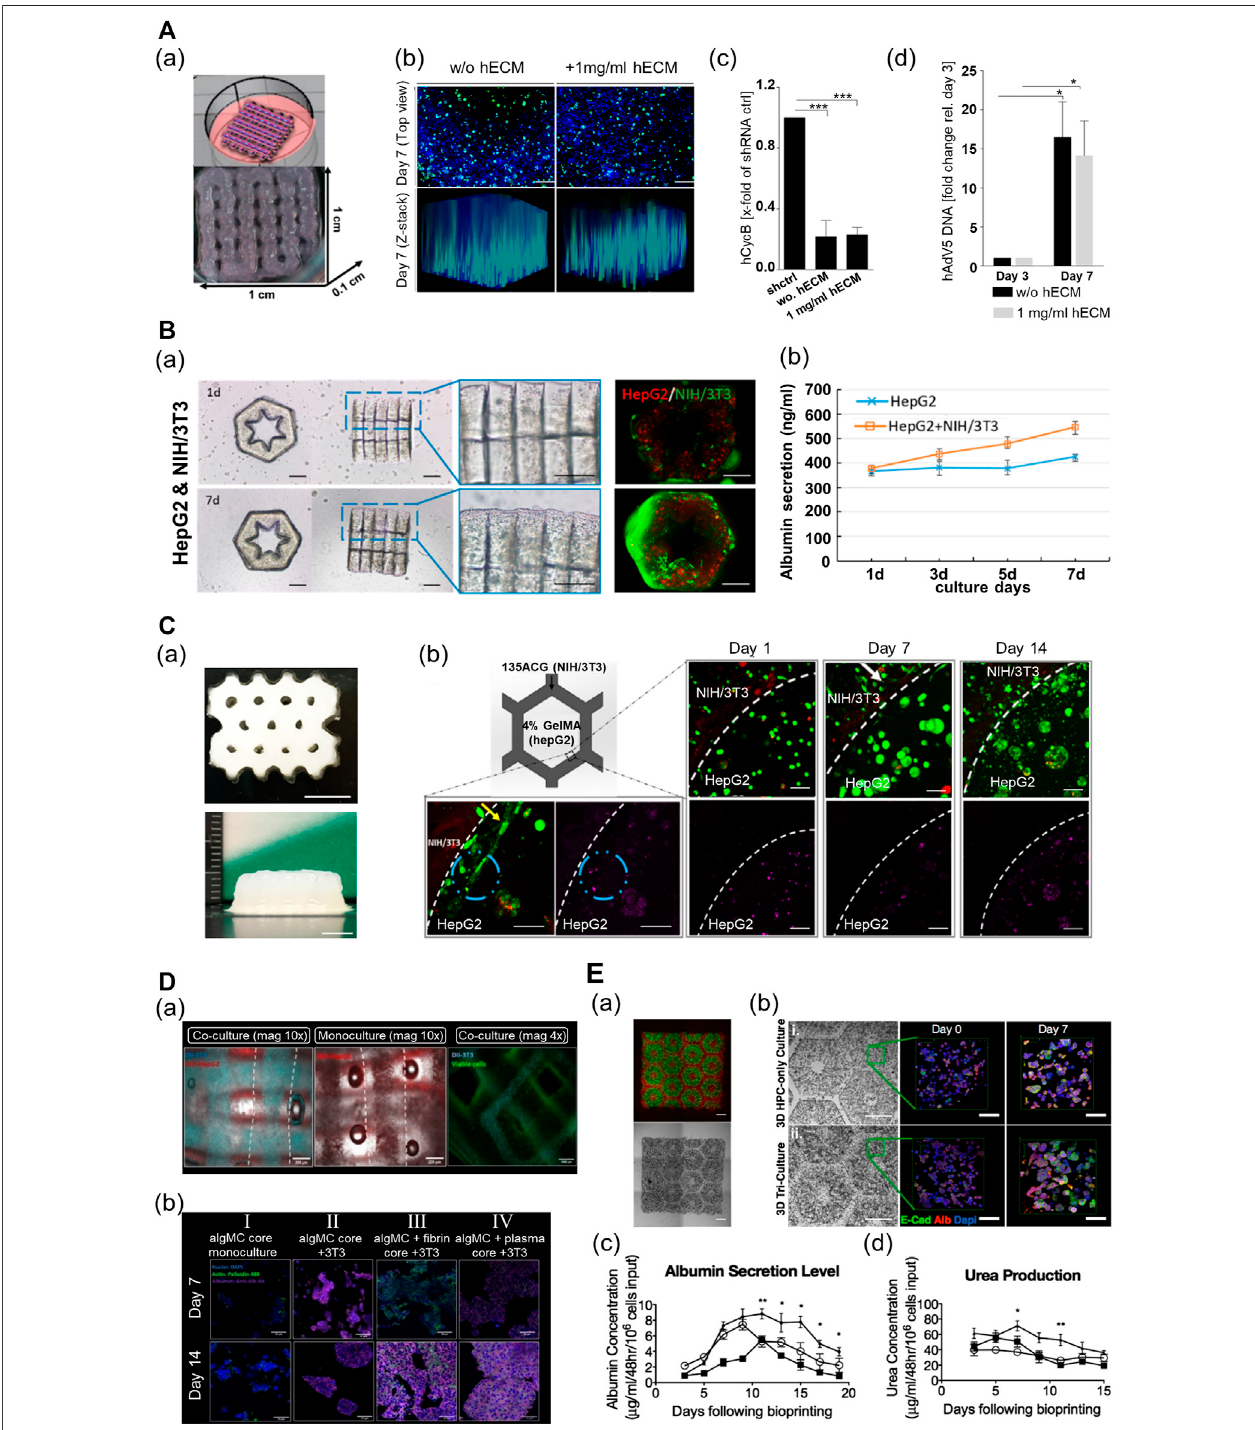
FIGURE7| Multi-componenthydrogelbioink-based3D-printedlivertissuemodels. (A) 3D-printedlivertissueforinfectionandtransduction studies.(a)3D-printed liver tissue construct with HepaRG cell-laden hybrid alginate – gelatin – human extracellular matrix (hECM). (b) Comparison of AAV2.6 transduction and distribution within the multi-component bioink-based 3D-printed liver tissue construct with hECM or without hECM 7 days after printing. Blue: nuclei, green: AAV vectors. Scale bar: 200 μ m. (c) Comparison of shRNA-mediated hCYcB RNA knockdown within the printed liver tissue construct with hECM or without hECM 7 days after printing. Resultsare shown asmean. *** p ≤ 0.001. (d) Comparison of adenovirus replicationwithinthe 3D-printed liver tissue construct withhECM or without hECM. Reproduced with permission from Hiller et al. (2018). (B) 3D lobule-like microtissue assembled with co-culture 3D-printed micromodules. (a) The proliferation of the cells within